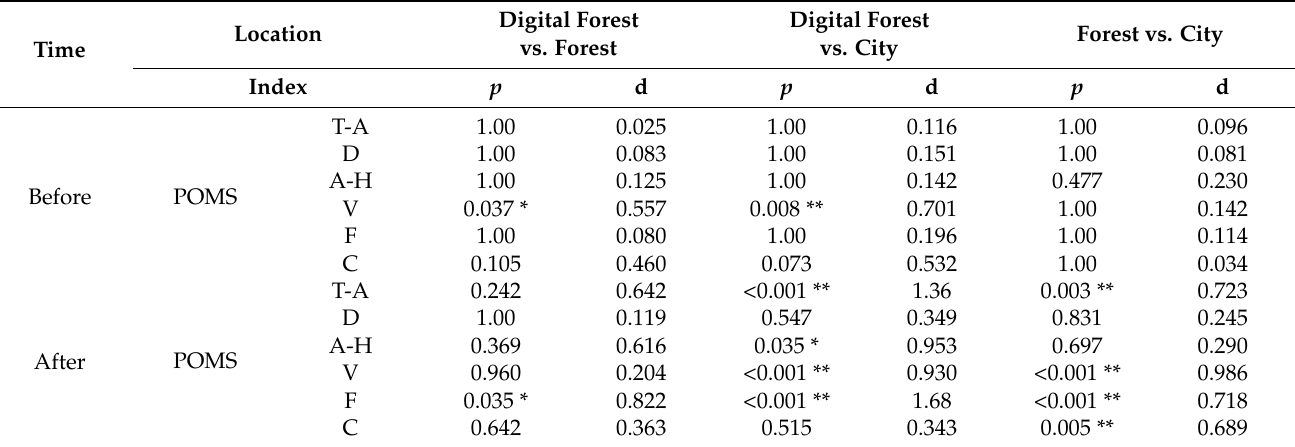
Table 8. Analysis results of POMS in three settings (multiple